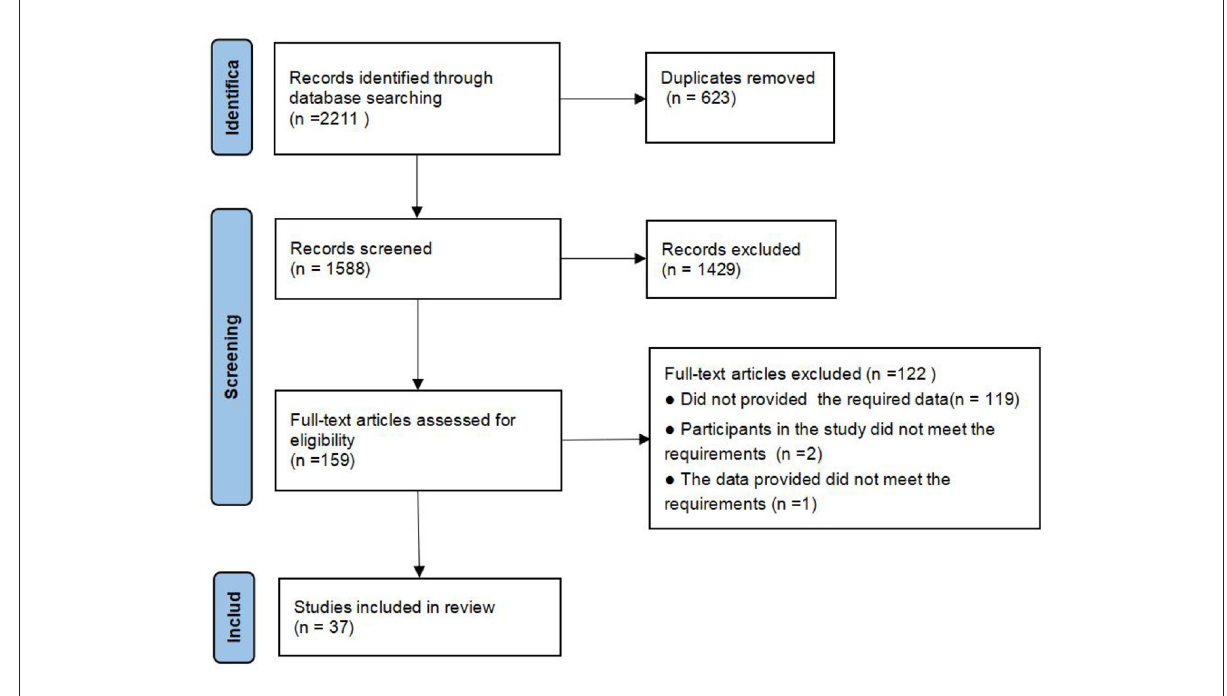
FIGURE1 Flow chart of PRISMA study.